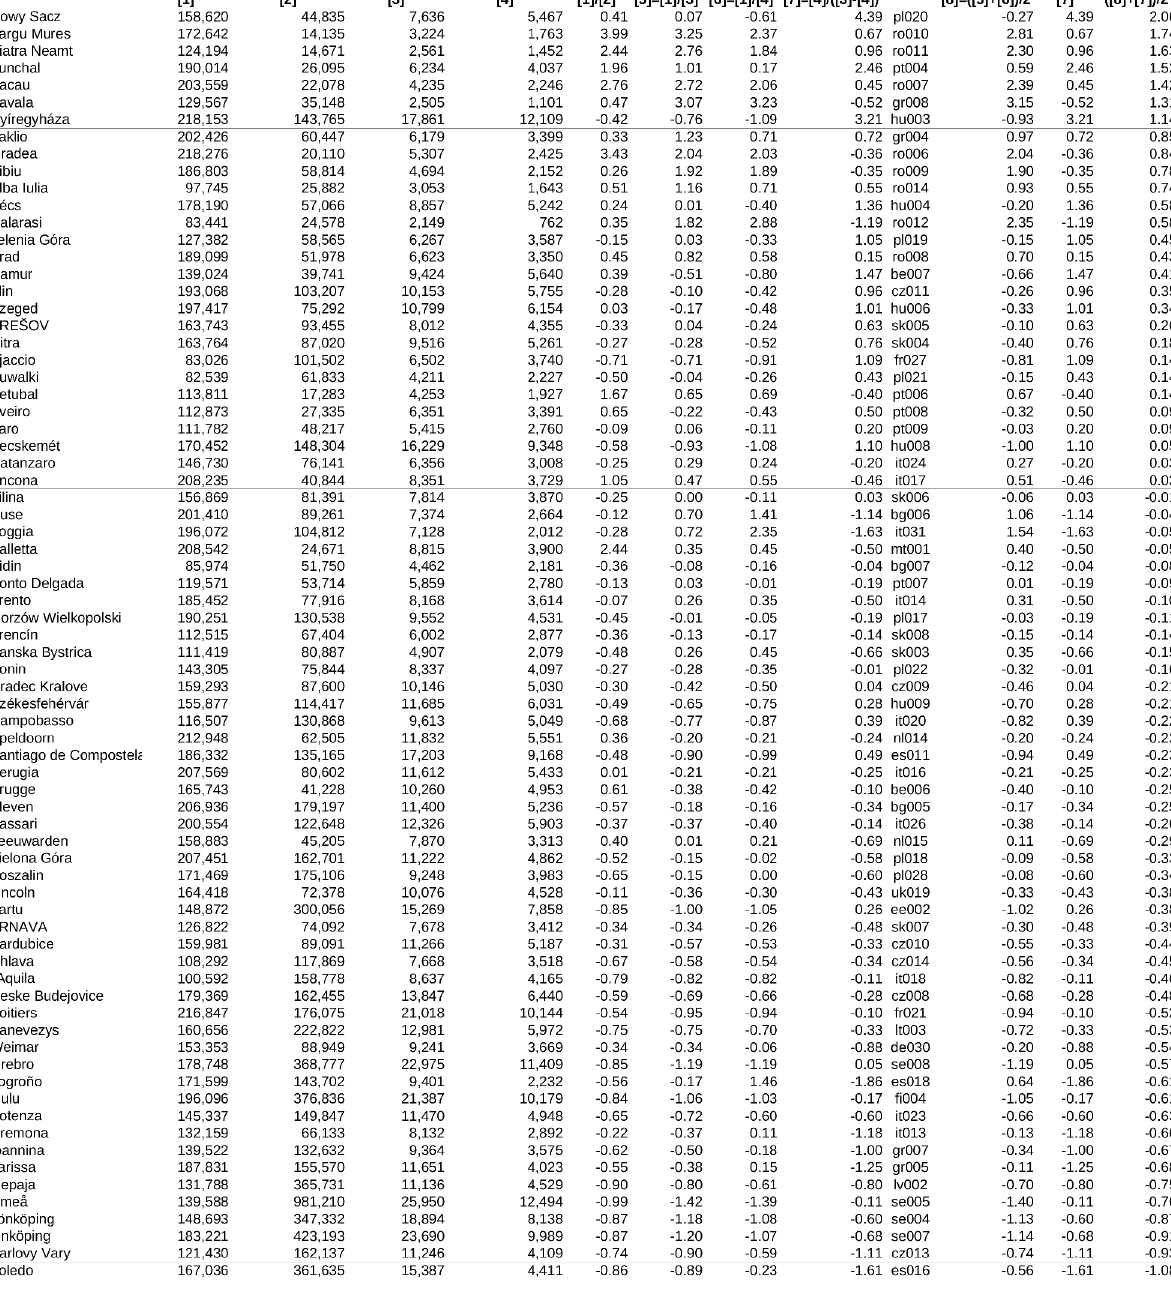
Table 2. Compactness and other data per LUZ. The most recent population data for Setubal and Lincoln is 2001 whereas for Pleven, Vidin and Ruse is